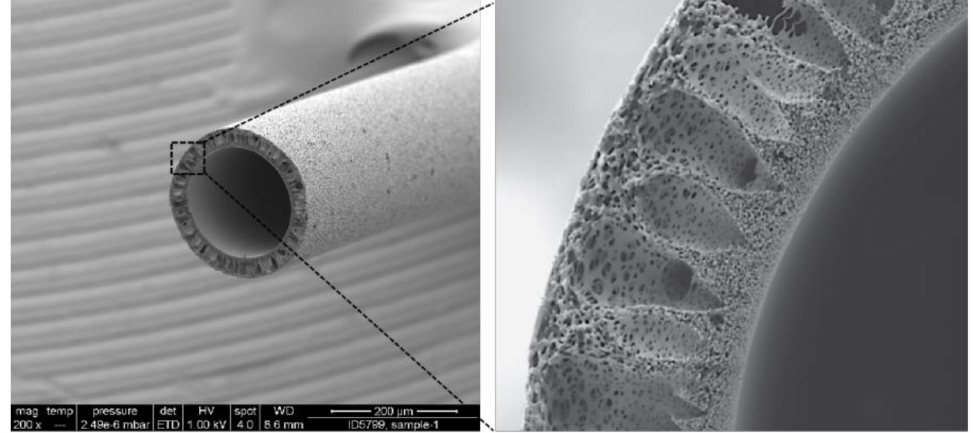
Figure 1. Scanning electron micrographs of fiber ( left ) and fiber wall ( right ). Pictures are from Baxter International, Inc., Deerfield, IL,